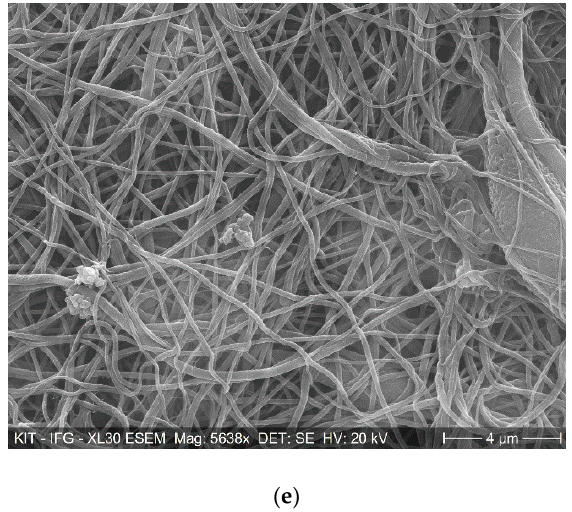
Figure 1. FE-SEM images of ( a ) UiO-66, ( b ) UiO-66-NH 2 , ( c ) polyvinylidene fluoride (PVDF) nanofibers, ( d ) pristine UiO-66-NH 2 composite nanofiber membrane (CNM), and ( e ) UiO-66-NH 2 CNM following the adsorption process. Figure 2 manifests patterns of XRD for UiO-66-NH 2 , UiO-66, the PVDF nanofiber,